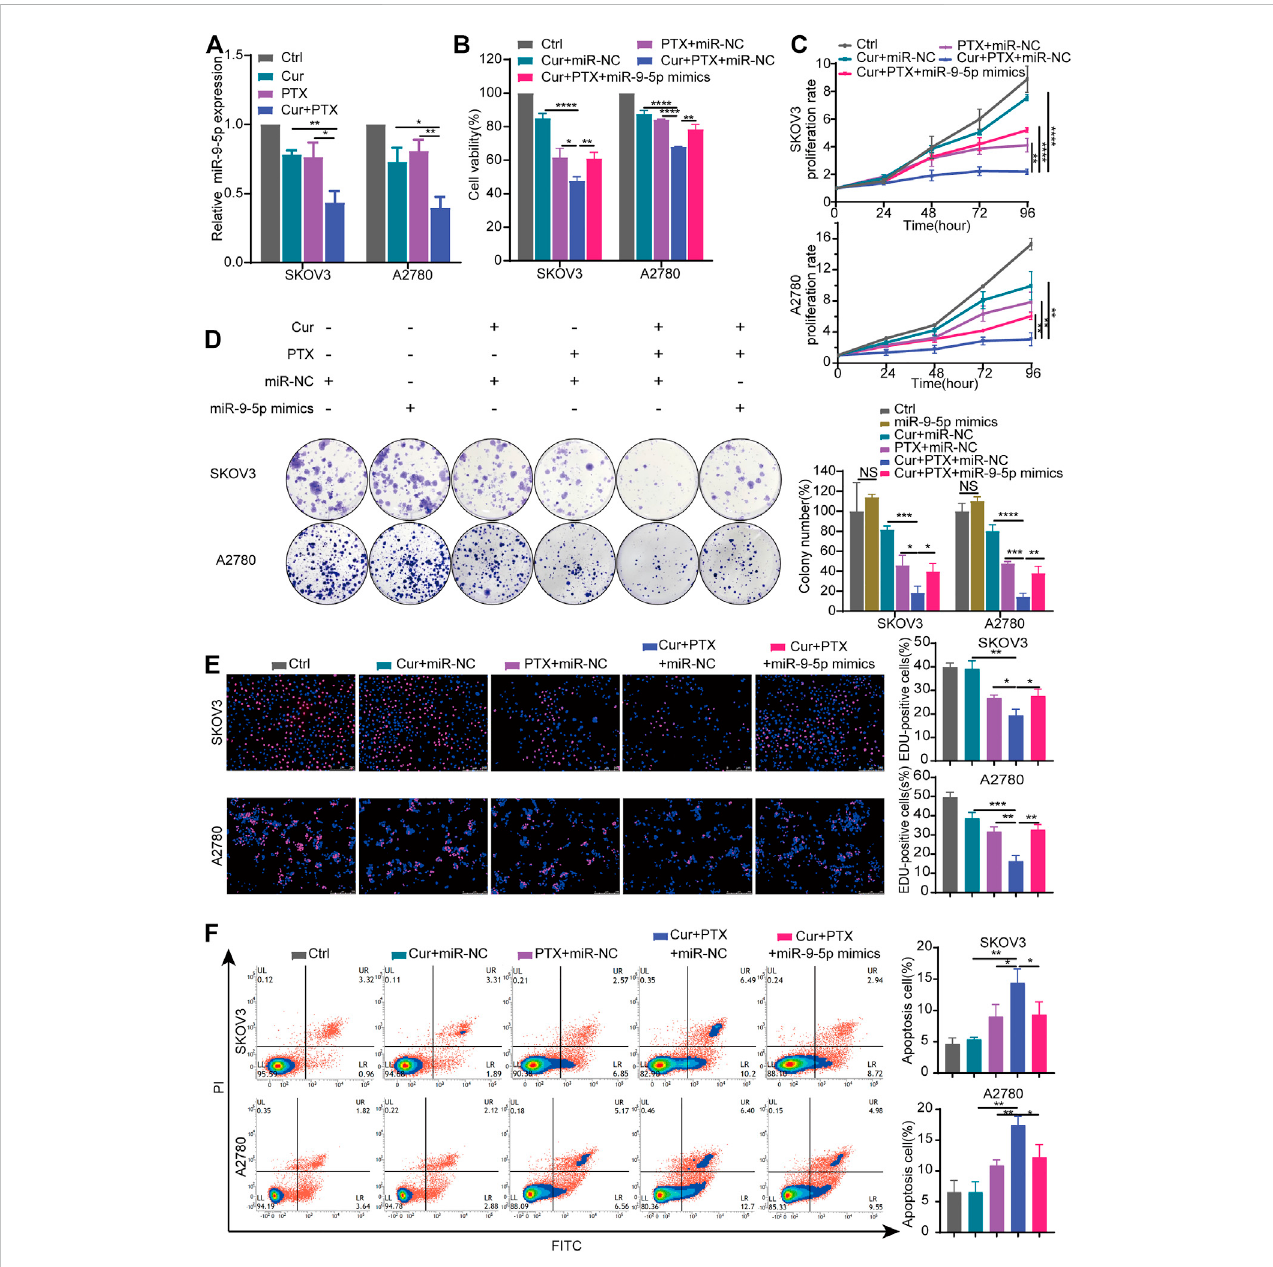
FIGURE 3 Overexpression of miR-9-5p counteracts the synergy between Cur and PTX in ovarian cancer cells. (A) The relative expression levels of miR-9-5p were detected by qRT-PCR in ovarian cancer cells treated with DMSO, Cur, PTX, or their combination. (B) Cell viability of SKOV3 and A2780 cells was detected by CCK-8assays.CellsweretreatedwithmiR-NCormiR-9-5pmimicsfor24 h,thencombinedtreatedwithDMSO,Cur,PTX,ortheircombinationforadditional 48 h. (C – E) TheproliferativecapacityofSKOV3andA2780cellswereassessedbyCCK-8assays,colony-formationassaysandEduincorporationassays. CellsweretreatedwithmiR-NCormiR-9-5pmimicsfor24 h,thencombinedtreatedwithDMSO,Cur,PTX,ortheircombinationfortherequiredtime. (F) Cell apoptosisafterindicatedtreatmentswasanalyzedbyFlowCytometry.Dataarerepresentativeofatleastthreeindependentexperimentsandpresentedasthe mean ± SD. * p < .05, ** p < .01, *** p < .001, **** p <